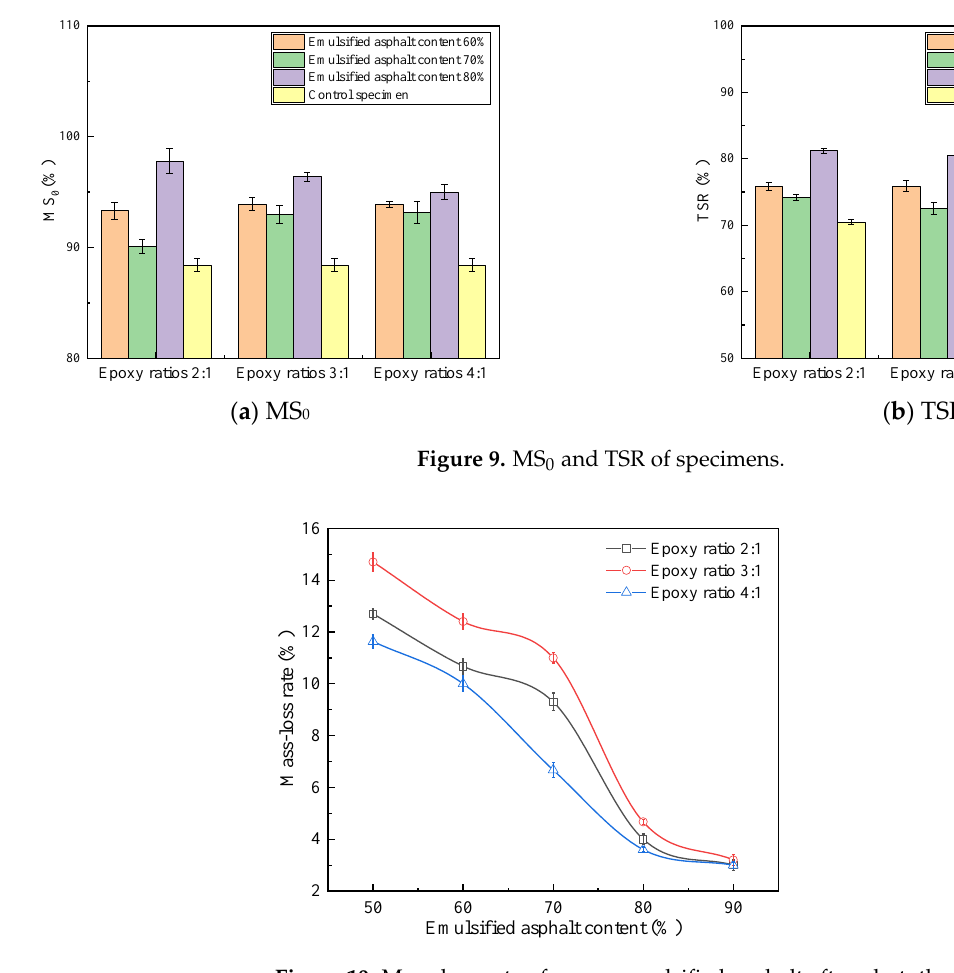
Figure 10. Mass-loss rate of epoxy-emulsified asphalt after photothermal aging.